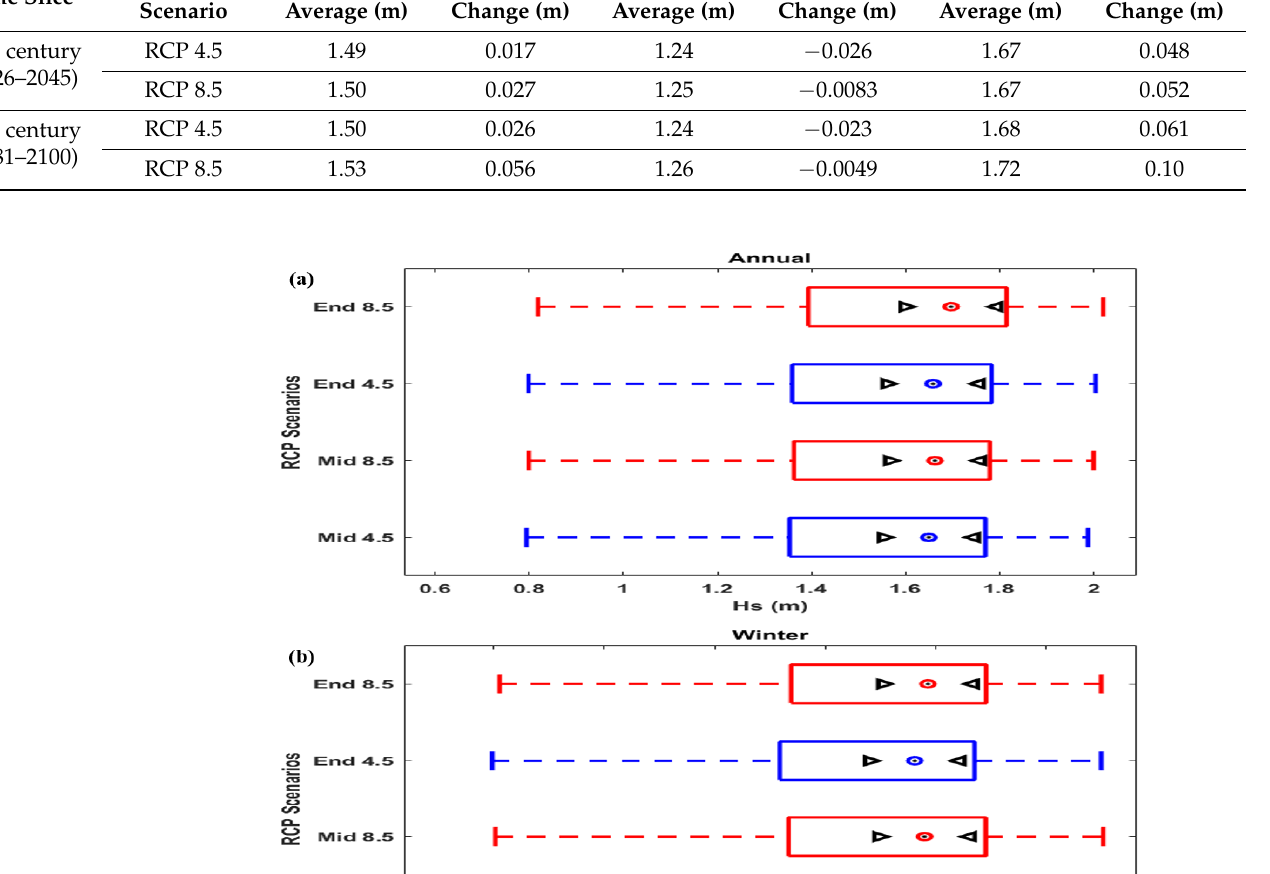
Table 5. Mid and end-century average extreme Hs and change relative to the past.